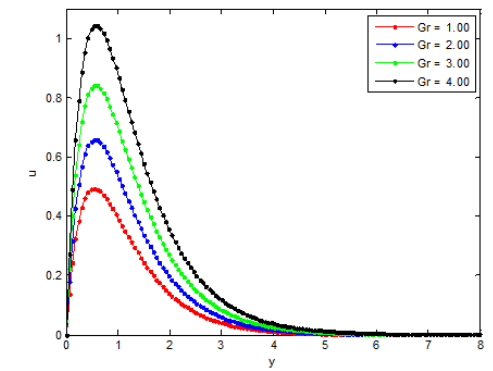
Figure 16. Effects of Grashof number on the velocity